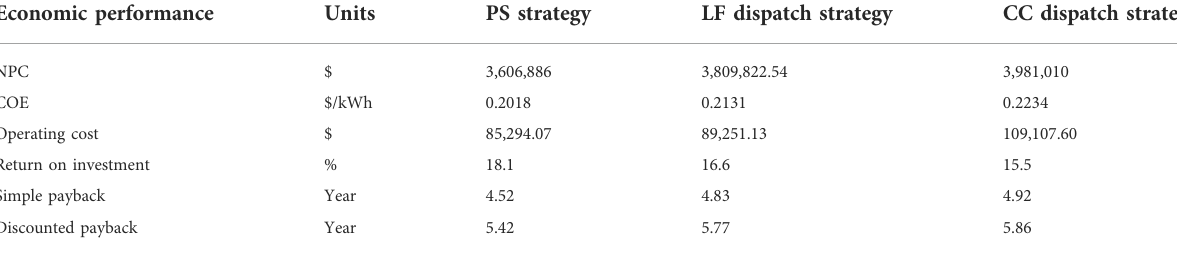
TABLE 6 Economic performance under different control